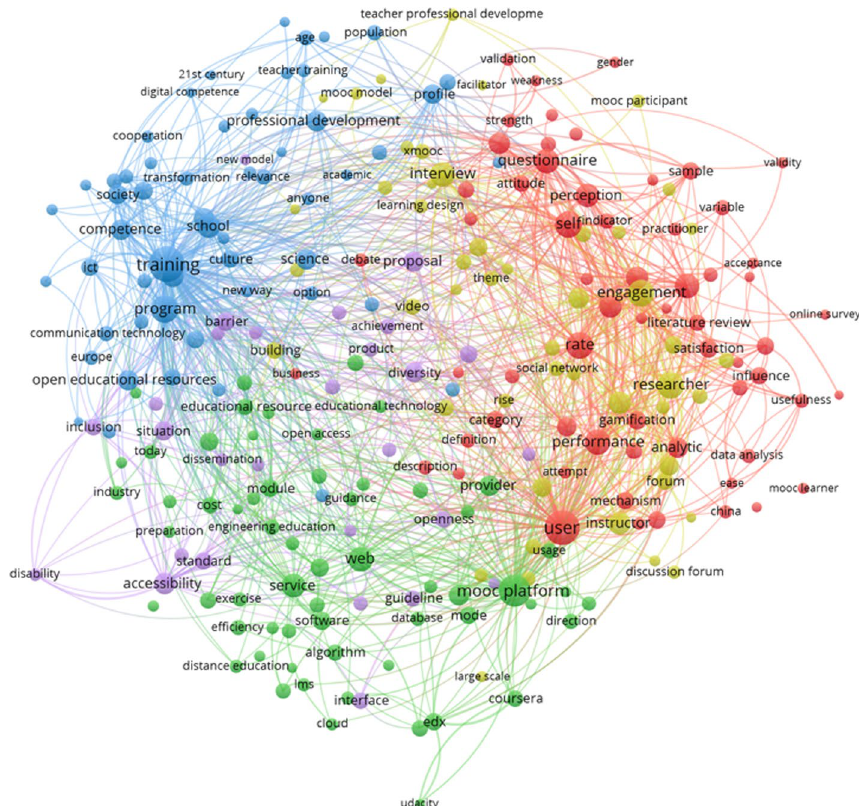
Fig. 7 Thematic cluster participation on MOOCs. Network